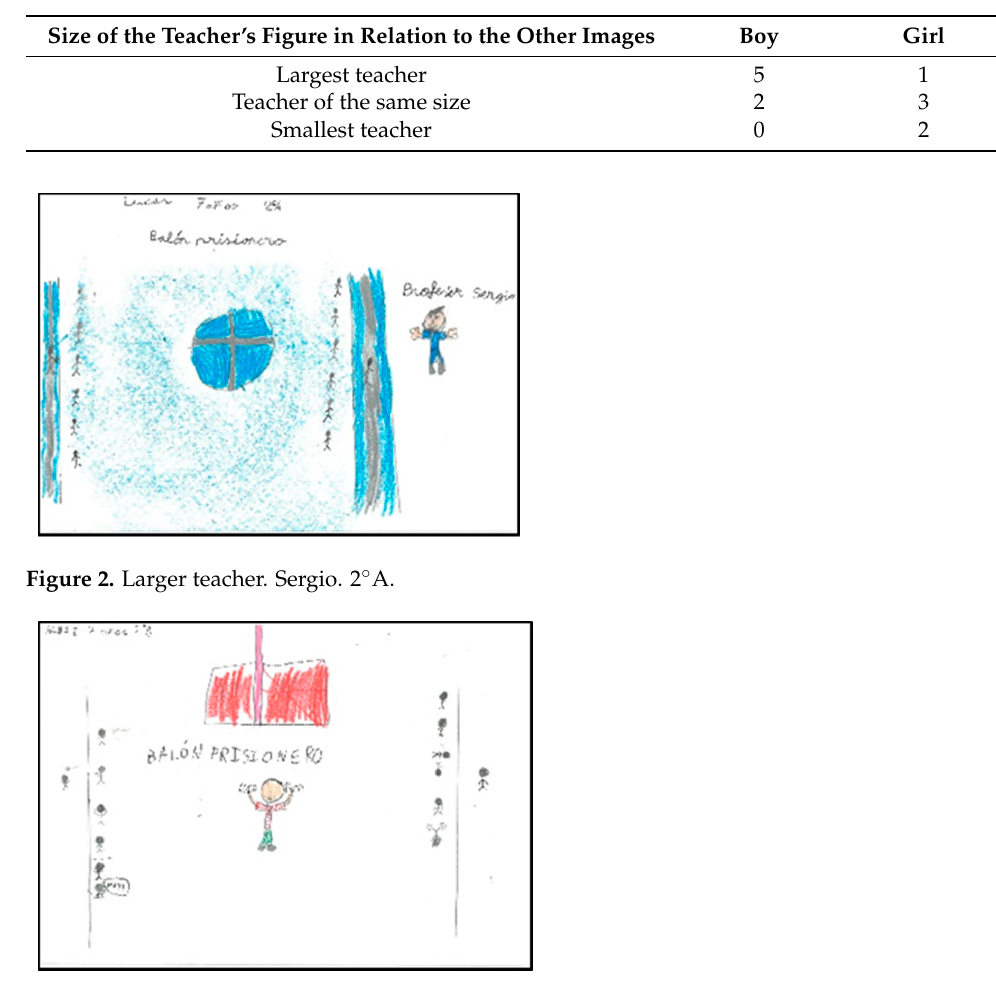
Figure 3. Teacher at a larger size. Alba. 2°A.